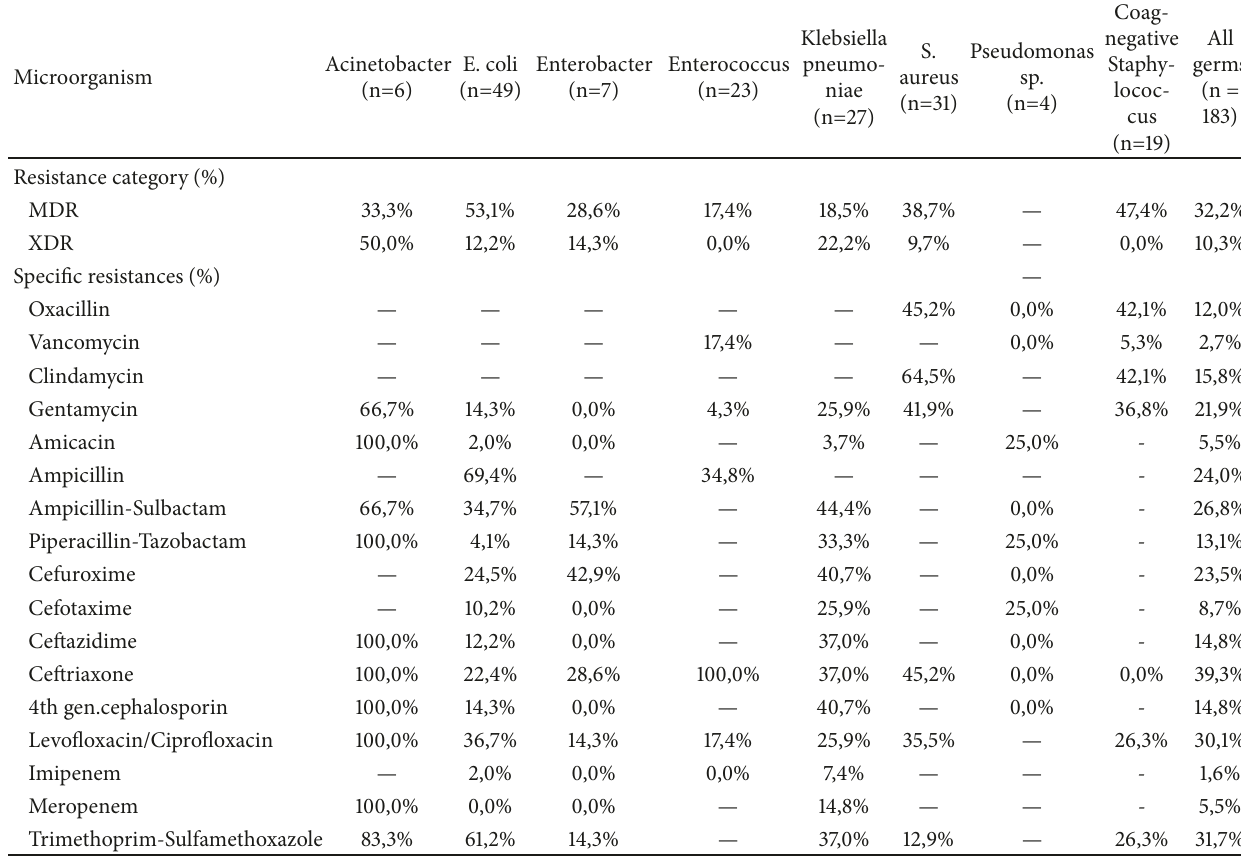
Table 2: Bacterial resistances of most prevalent germs against specific antibiotics among all cultures.